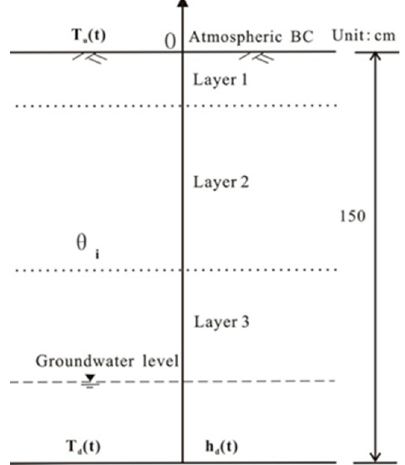
Figure 7. A conceptual model of hydrogeology.